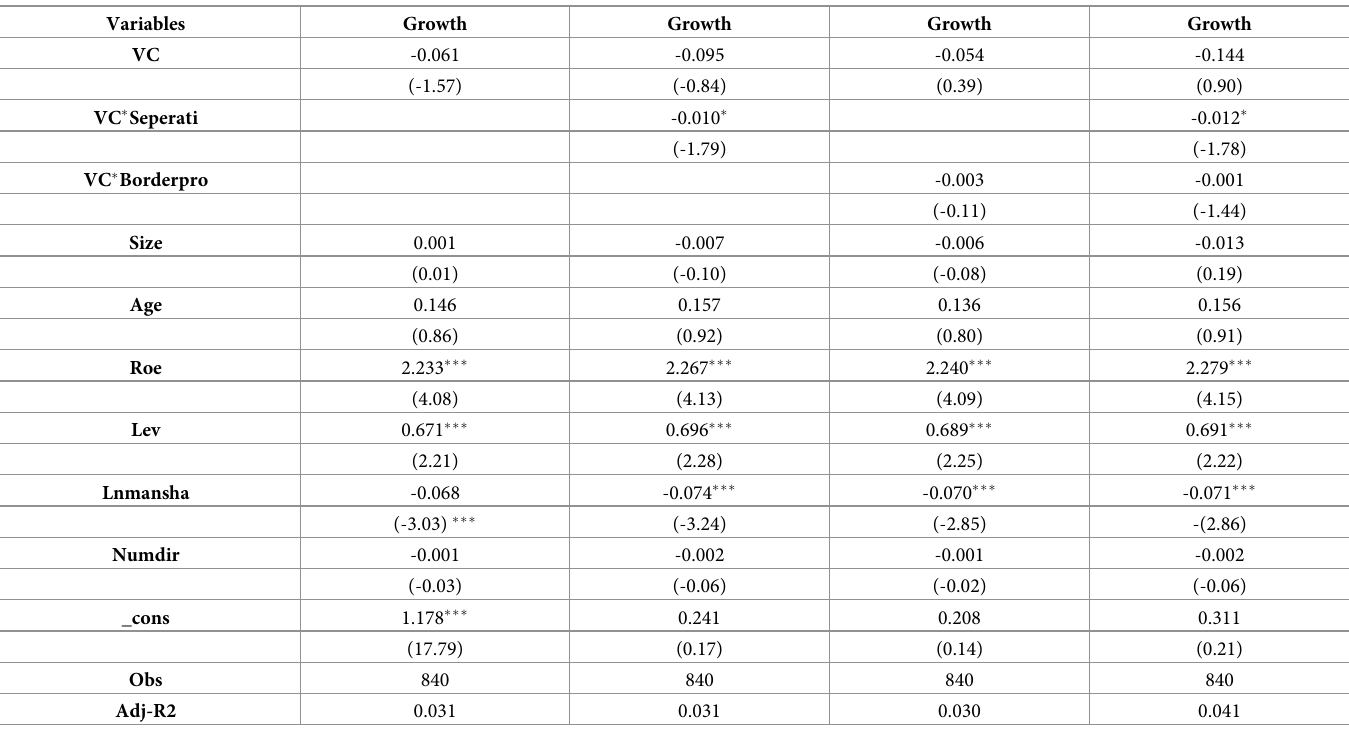
Table 3. State adjustment effect test of family control